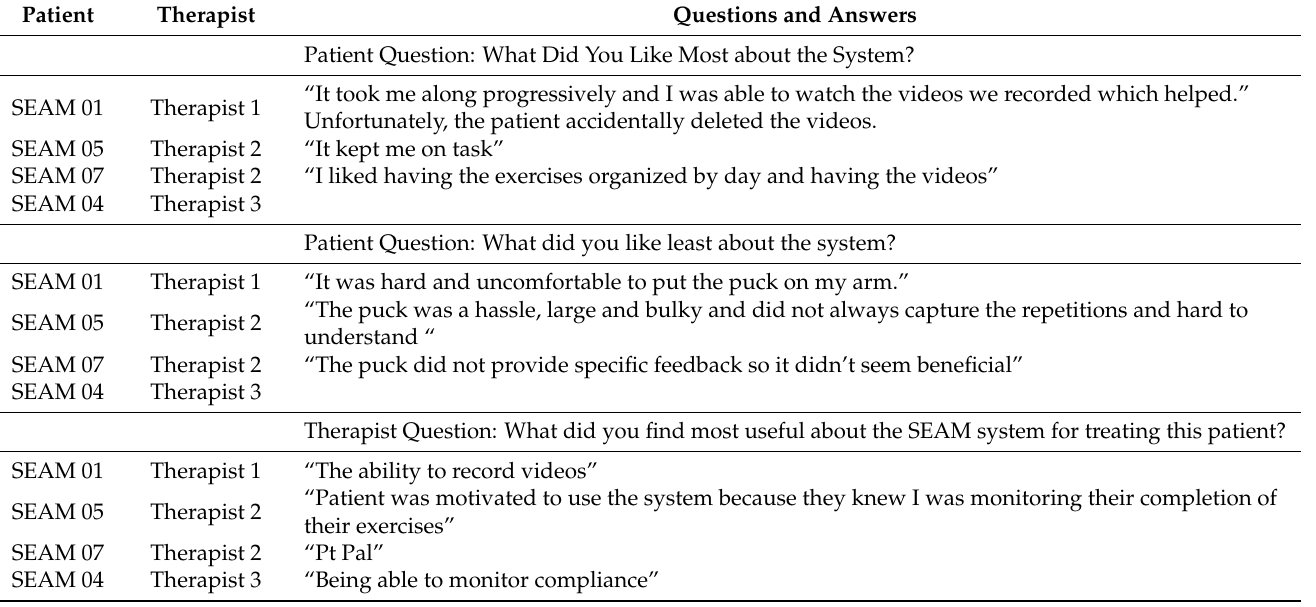
Table 6. Patient and therapist responses to questions at discharge. SEAM 04 self-discharged before the discharge survey could be delivered and thus the survey response only includes the parts from their therapist, Therapist 3. Patient Therapist Questions and